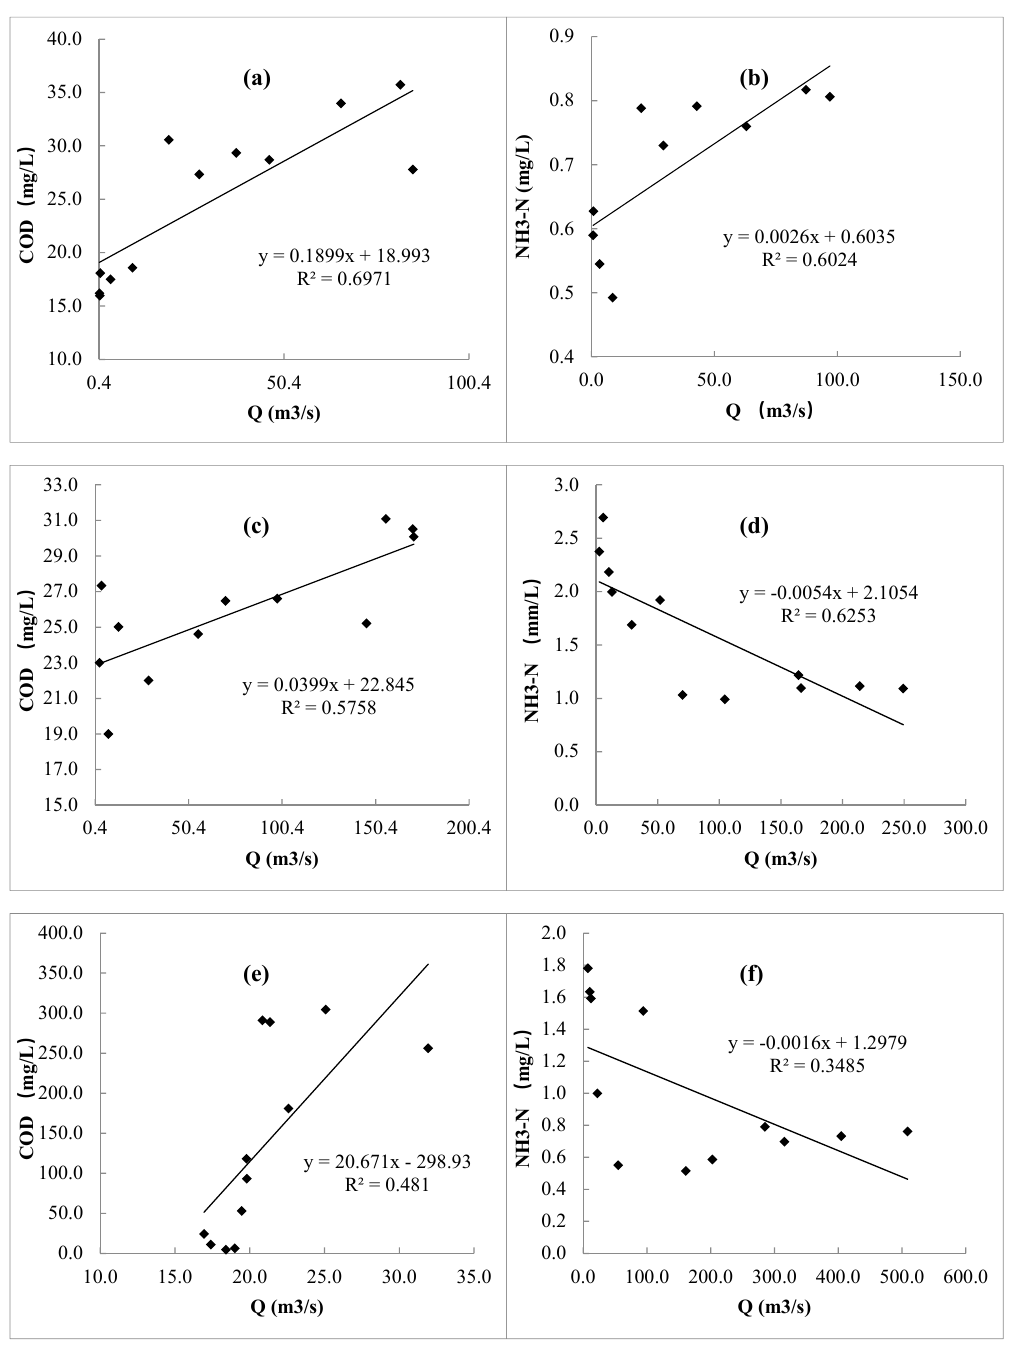
Figure 6. Correlation between perennial monthly mean concentration and flow. ( a ) Upstream reaches, COD and flow; ( b ) upstream reaches, NH 3 -N, and flow; ( c ) middle reaches, COD, and flow; ( d ) middle reaches, NH 3 -N, and flow; ( e ) lower reaches, COD, and flow; ( f ) lower reaches, NH 3 -N, and flow (COD: chemical oxygen demand; NH 3 -N: ammonia nitrogen).